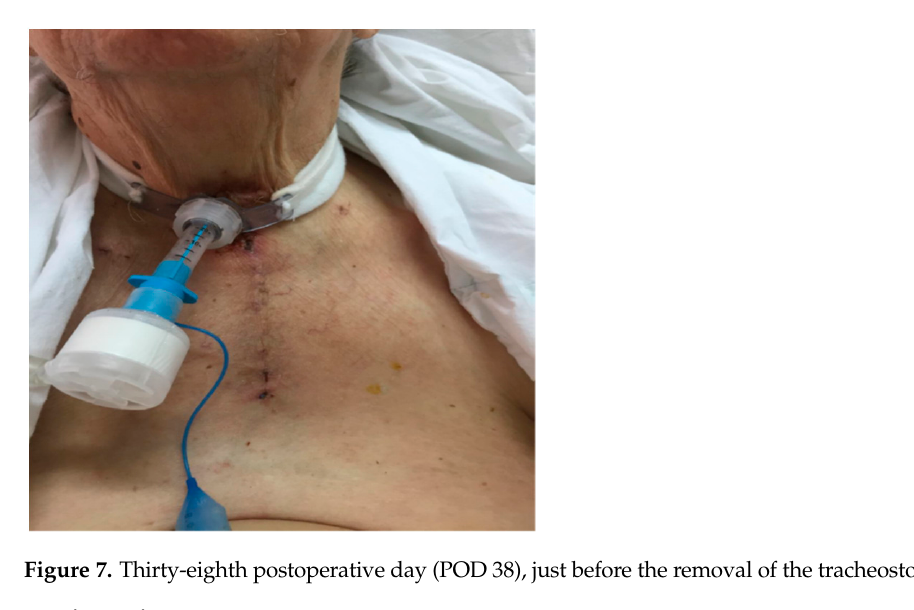
4 of 7 Figure 5. The residual cavity after the surgical removal of the substernal goiter. Figure 6. The thyroidectomy specimen.